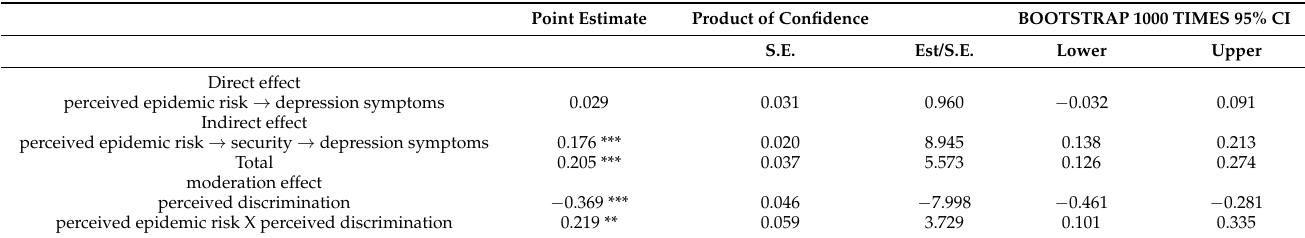
Table 2. Bootstrap mediation and mediated moderation effect ( N =